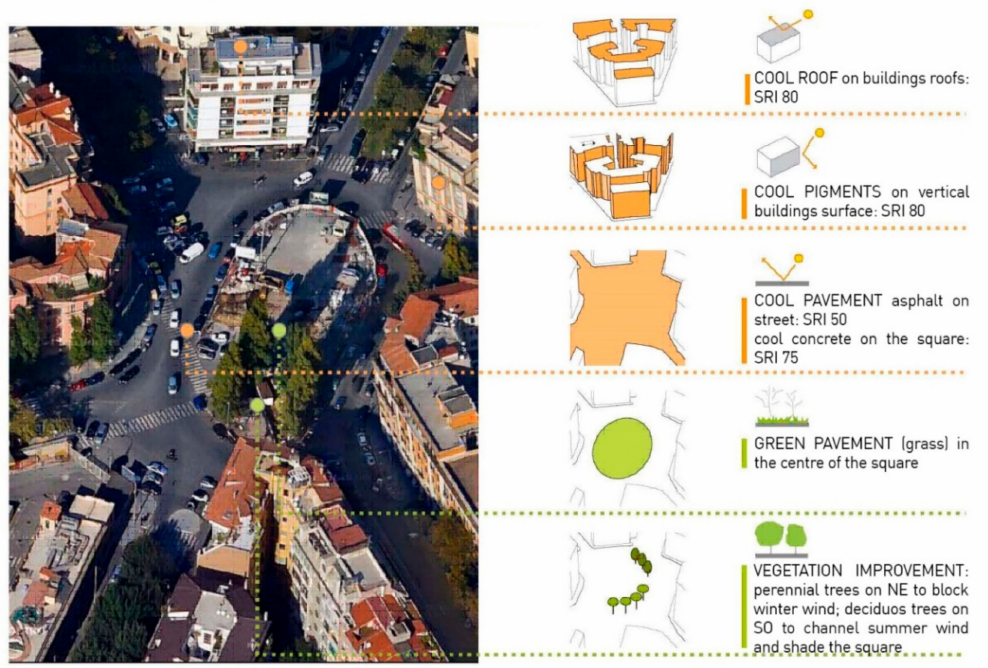
Figure 7. Scenario of intervention 2: surface renovation and vegetation